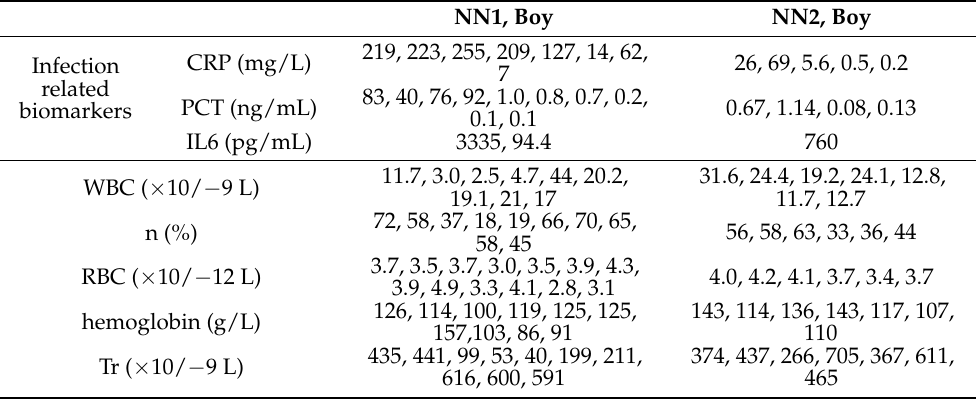
Table 2. Relevant hematological, biochemical, immunological, and microbiological results. NN1, Boy NN2,